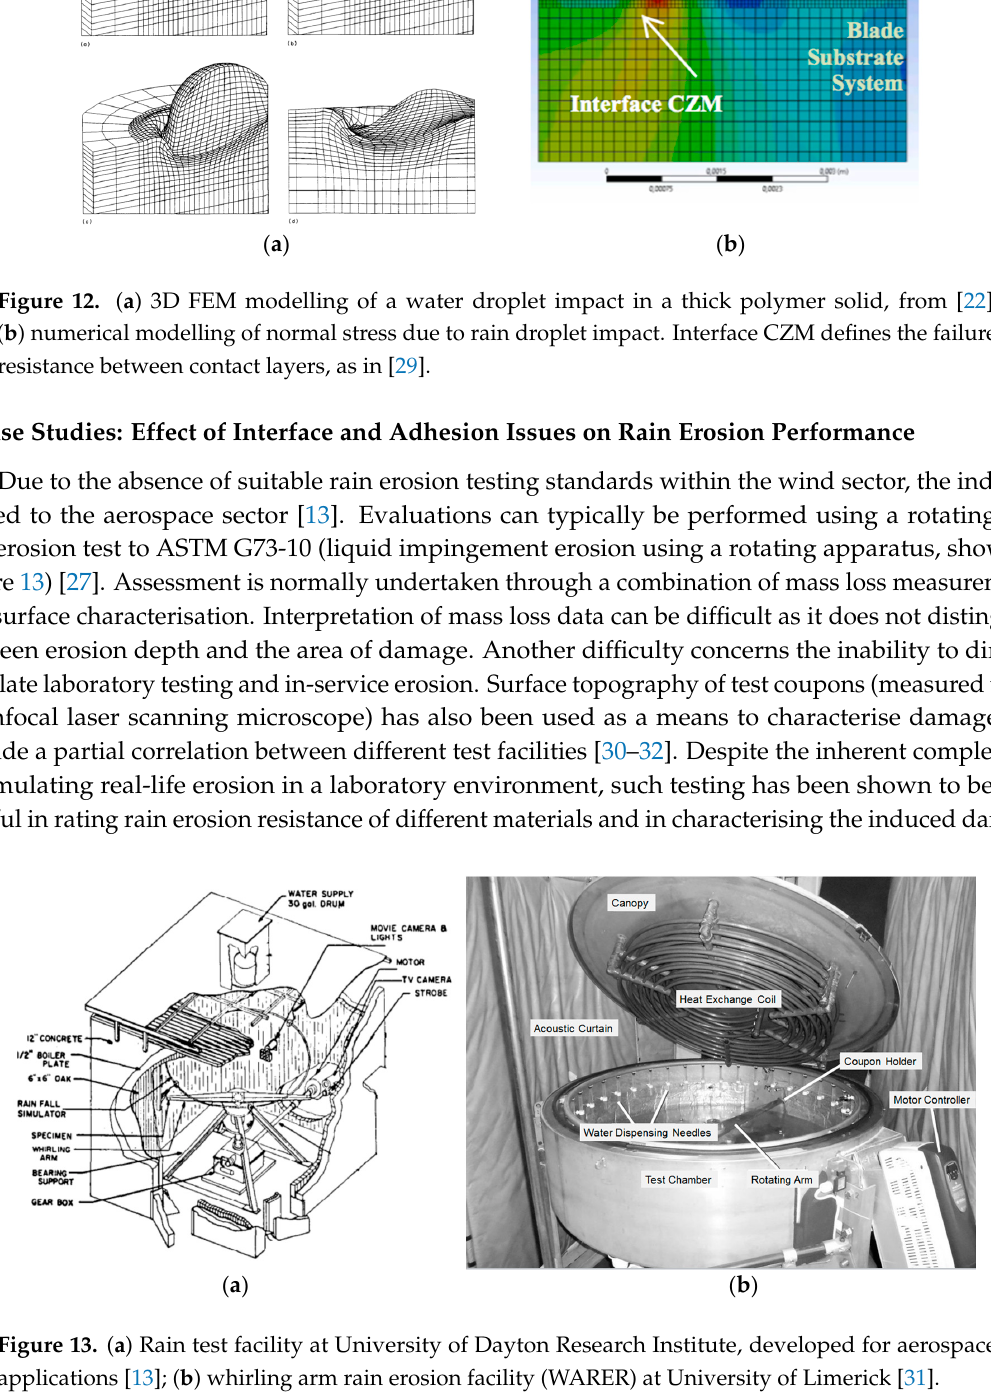
( b ) Figure 11. ( a ) Representative evolution of weight loss on experimental rain erosion testing samples, from [23]; ( b ) lifetime prediction model defining the incubation period and mass removal rate. In order to predict the incubation time and the mass removal rate, the stress history in the coating and in the substrate has to be identified analytically or numerically. It is affected by the shockwave progression due to the vibro-acoustic properties of each layer, and by the frequency of the repeated water droplet impacts. Fatigue life of the material is calculated using an equivalent dynamic stress with a semi-empirical approach and depends on the ultimate tensile strength and other relevant properties of both the coating material and substrate. The model can be applied to estimate the stress at different locations through the thickness, i.e., the coating surface or at the coating–substrate interface. Nevertheless, it is assumed that the bond and adhesion of the boundary interface is ideally perfect, so the modelling does not account for the microstructural imperfections and lack of adhesion of such interfaces. The appropriate development of numerical modelling of rain droplet impact can also be used to